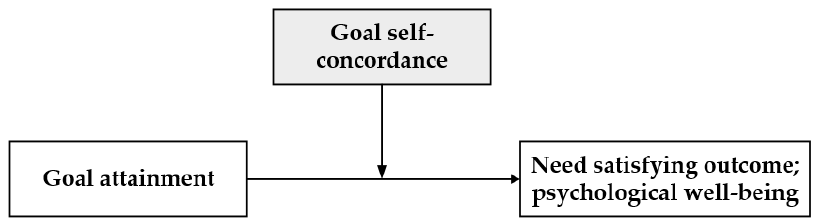
Figure 1. Self-concordance model.